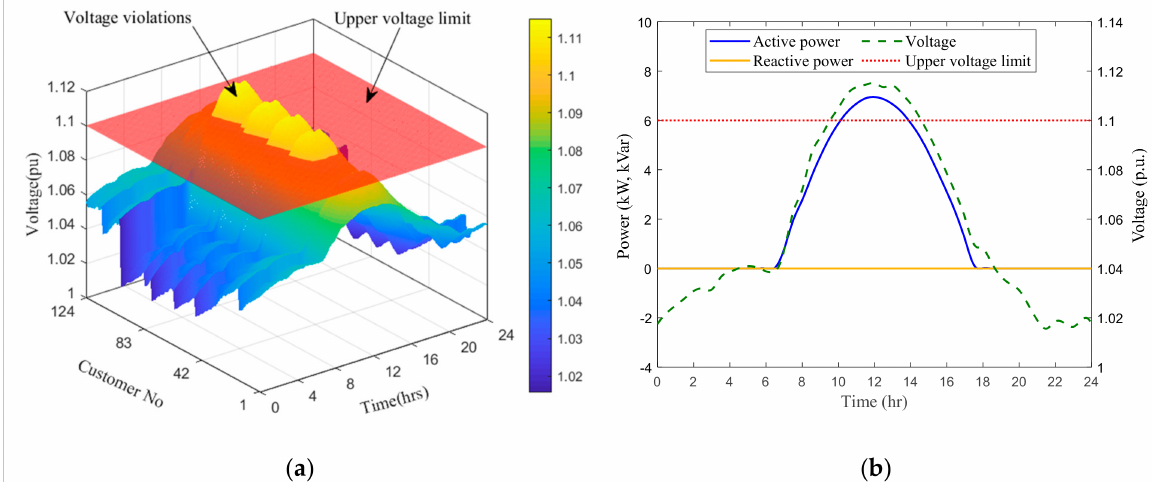
Figure 8. Daily variations of ( a ) the voltage of all customer nodes and the ( b ) terminal voltage and active and reactive power output of the PV inverter connected to the critical node with no reactive power control for the sunny climatic condition.